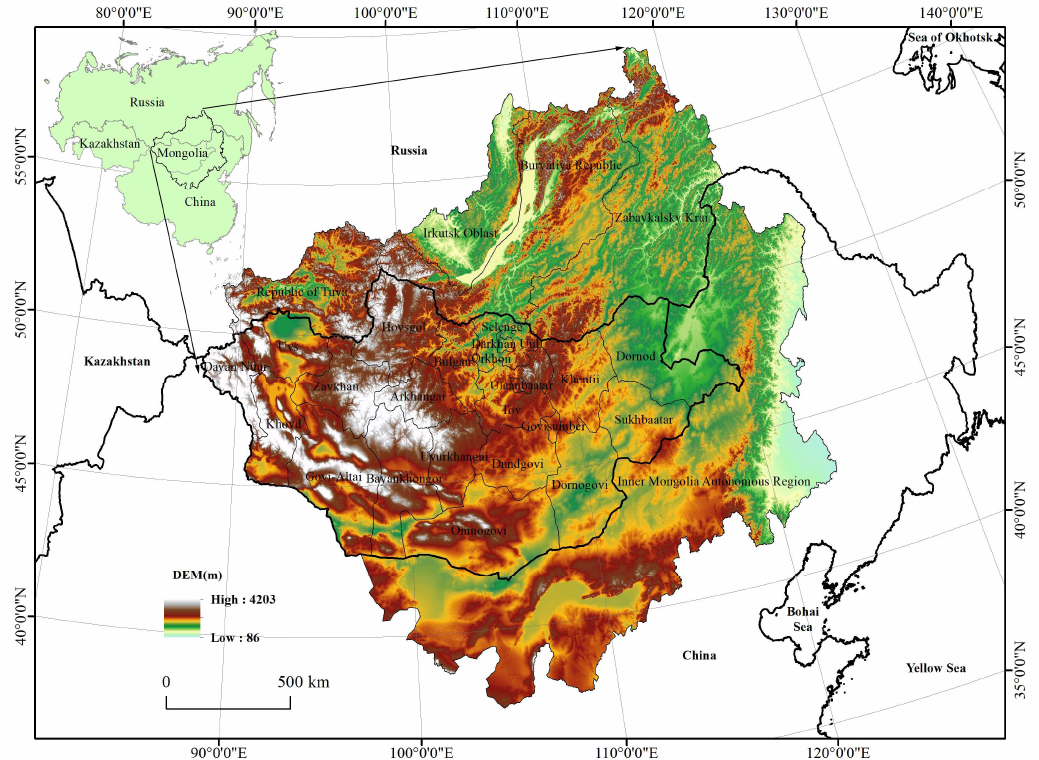
Figure 1. Geographic location and elevation of the Mongolian Plateau (MP).